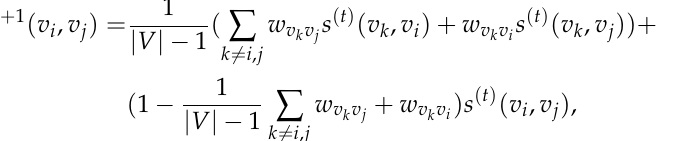
= 2 = 5 , and Q ∗ . Hence, likelihood 6 αβ ββ 12 2.701 × 10 − 6